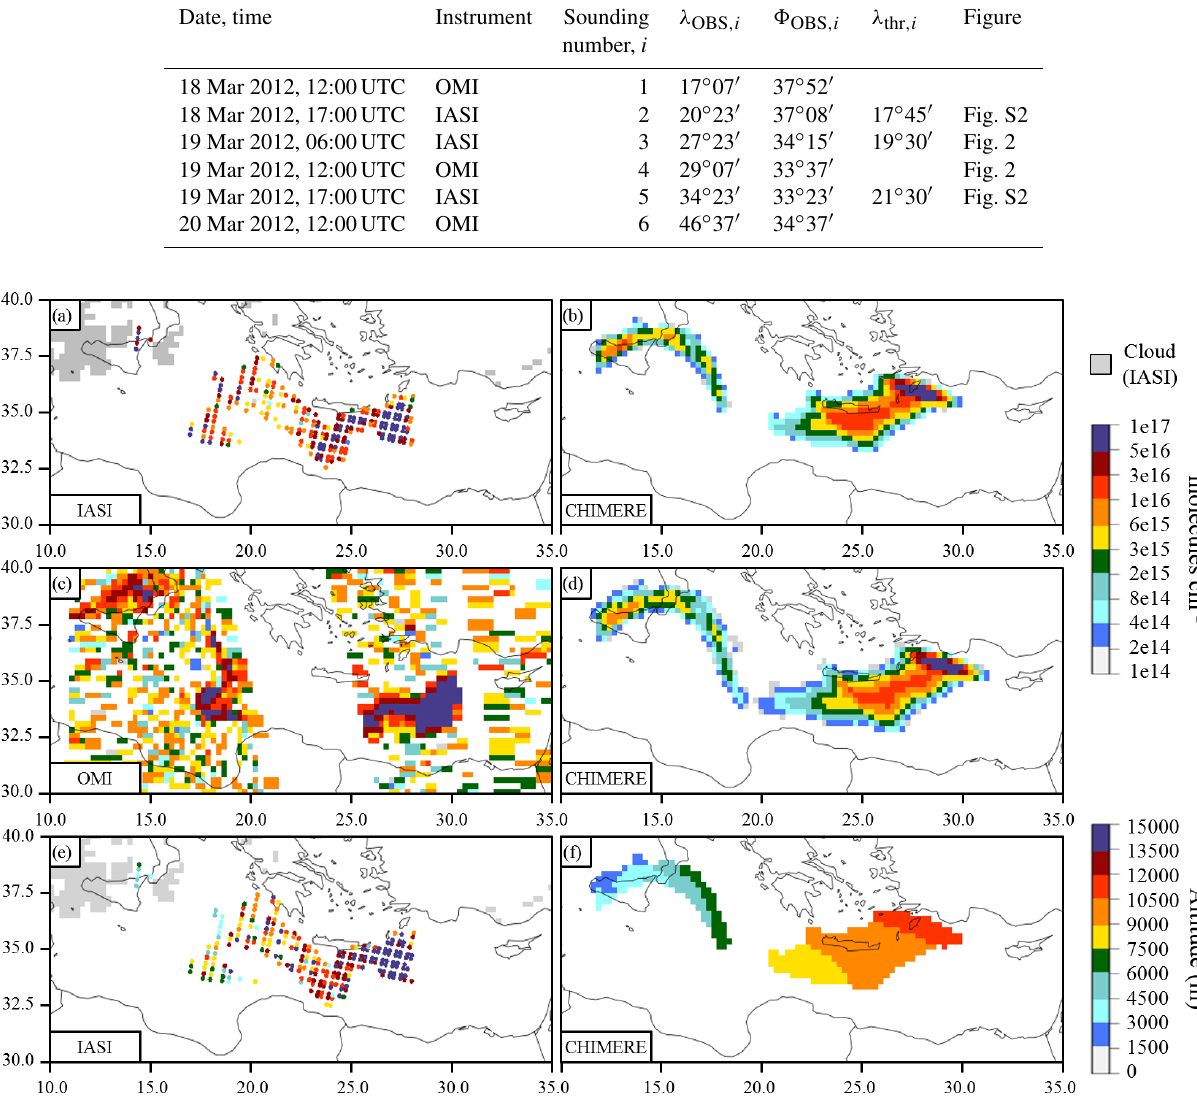
Figure 2. The IASI SO 2 plume (a) , the OMI SO 2 plume (c) , and the respective IASI and OMI soundings for 19 March 2012 at 06:00 and 12:00UTC (3 and 4 in Table 3). The CHIMERE SO 2 plume (b, d) , in molecules per square centimeter (molec . cm − 2 ), corresponding to the IASI and OMI soundings. The IASI SO 2 altitude (e) and the CHIMERE SO 2 maximum concentrations’ altitudes (f) , in meters (m), for 19 March 2012 at 06:00UTC. In this example, the CHIMERE simulation WRFW-DL-20 is displayed. CHIMERE and OMI data are represented on OMI’s 0.25 ◦ × 0.25 ◦ resolution grid. Clouds are based on Advanced Very High Resolution Radiometer (AVHRR) data for IASI. A log scale is used to better visualized CHIMERE simulations, but values under 3 × 10 15 ( ∼ 0 . 1DU) are below satellite detection